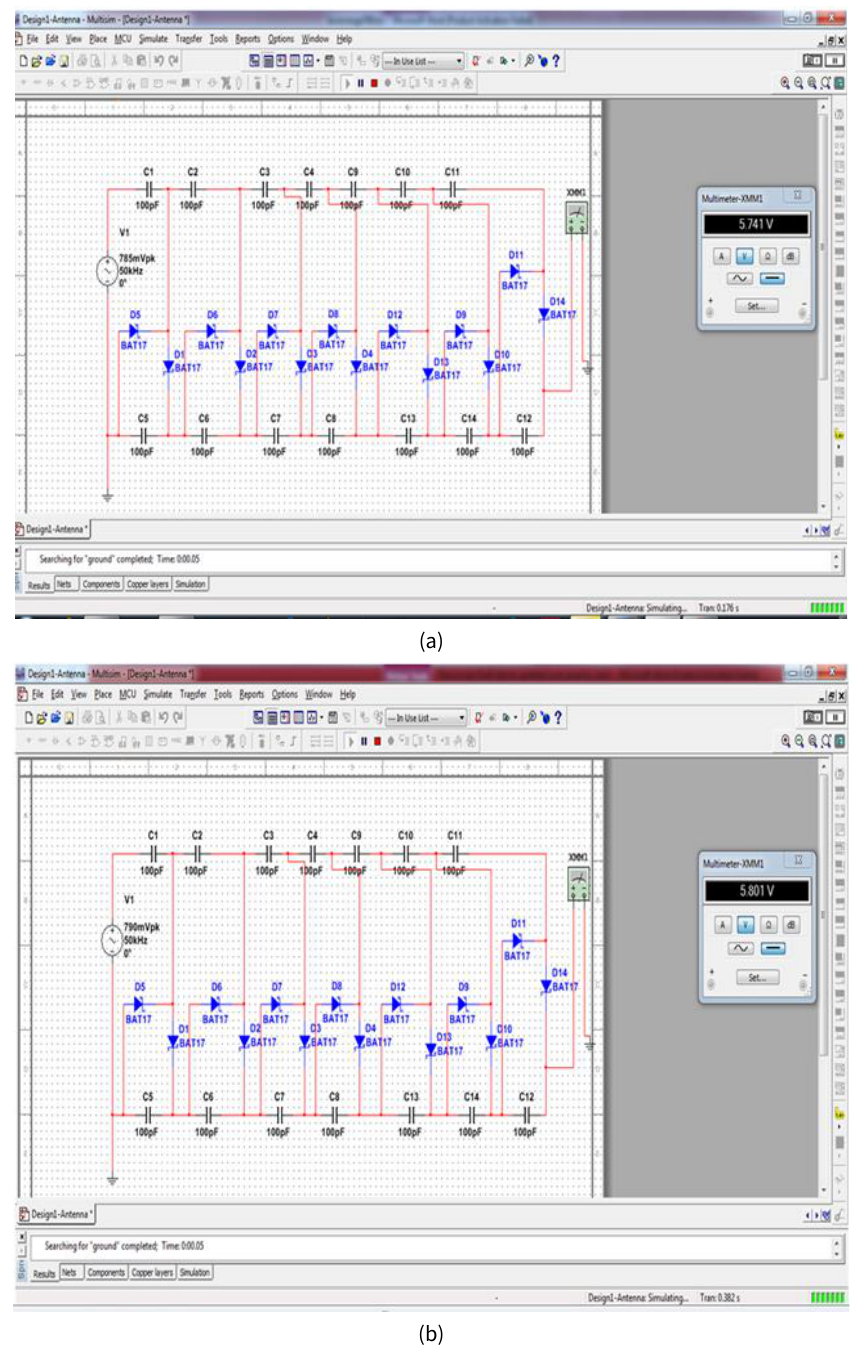
Figure 4. (a) The architectural system design using 935MHz (b) The architectural system design using 960MHz The simulation results illustrated in Figures 4(a) and 4(b) corresponds to the 935MHz and 960MHz frequencies respectively, and the comparison shows very little difference in the voltage